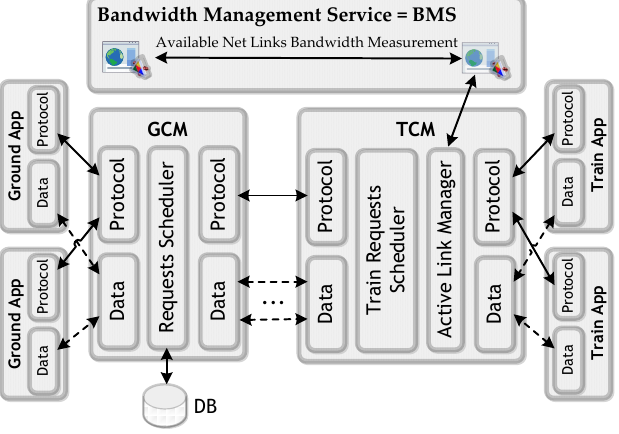
Figure 2. Train-to-ground communication middleware